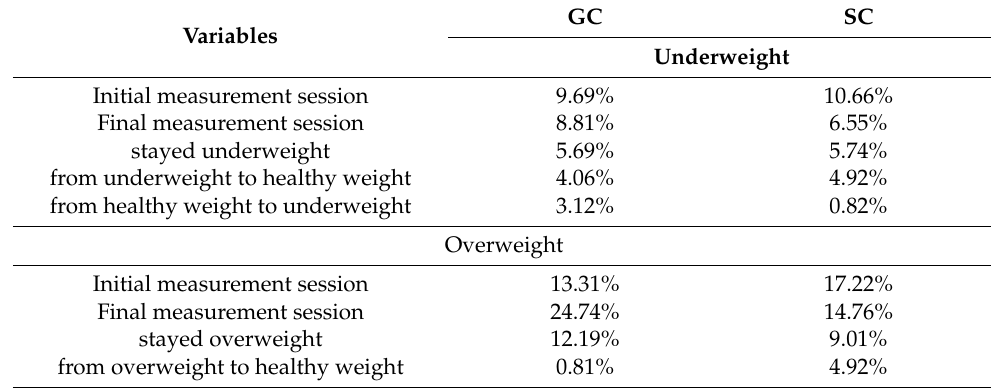
Table 4. The variability of the percentage of children in particular body mass categories from the initial to the final measurement